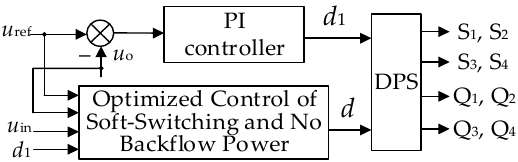
Figure 10. The optimized control of soft ‐ switching and no backflow power.